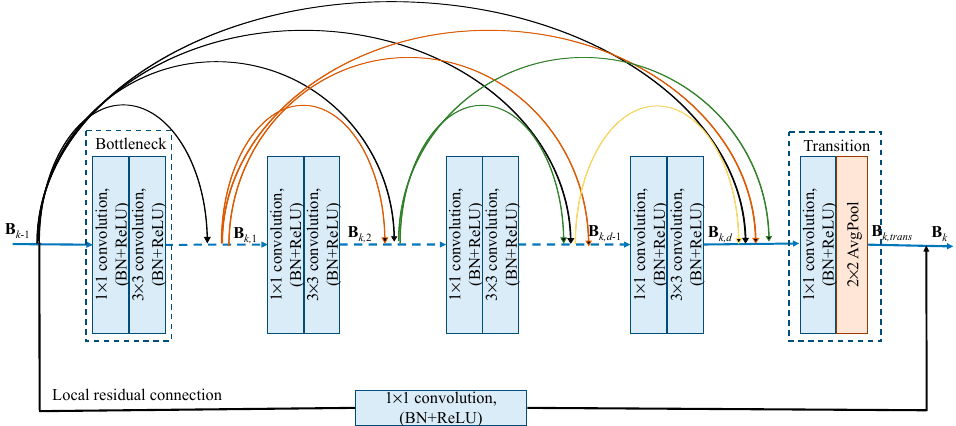
Figure 2. Structure of residual dense block.